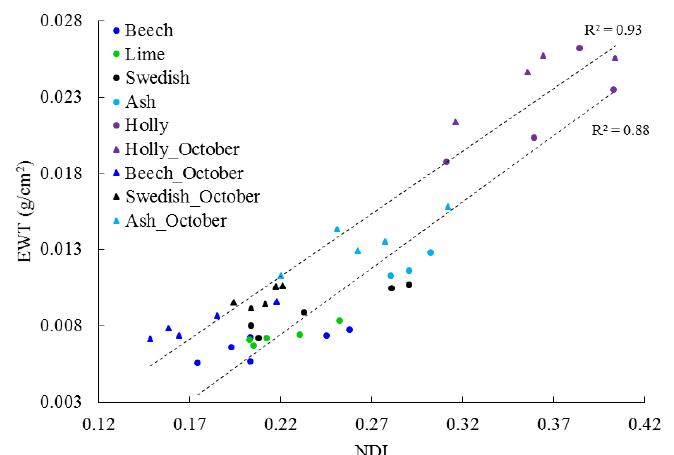
Figure 3. The NDI–EWT pooled model in the August dataset, after excluding the sycamore leaves Figure 3. The NDI – EWT pooled model in the August dataset, after excluding the sycamore leaves (bottom), and the NDI–EWT pooled model in the October dataset (top). A shift can be seen between (bottom), and the NDI – EWT pooled model in the October dataset (top). A shift can be seen between the two trendlines, most likely caused by leaf senescence. the two trendlines, most likely caused by leaf senescence.